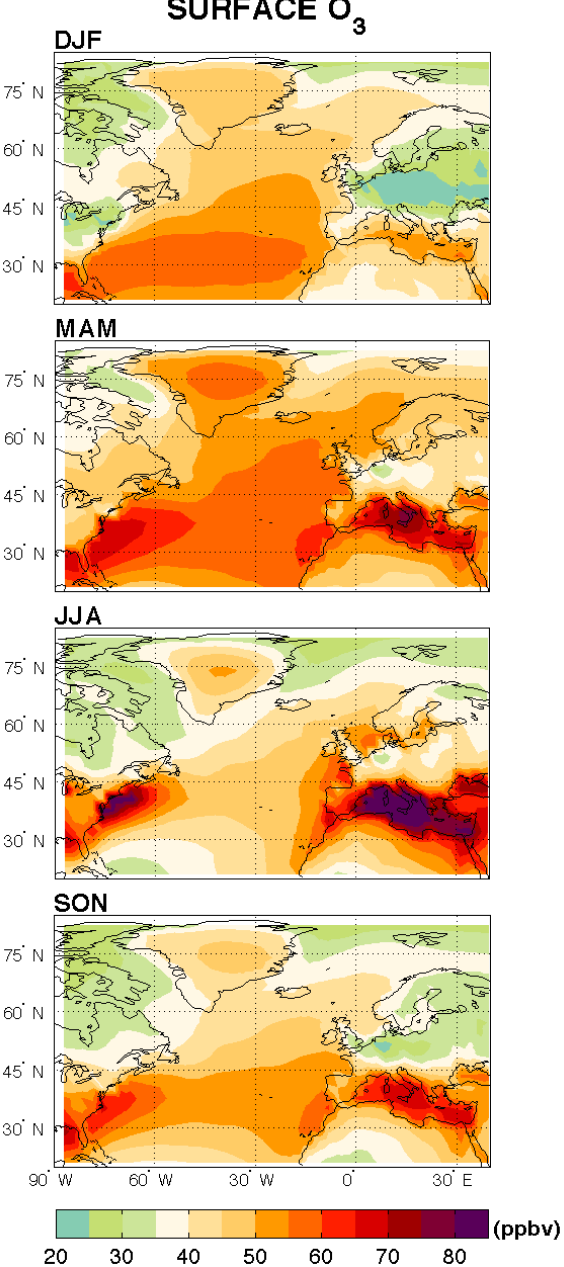
Fig. 2. Seasonal climatology (1980–2005) of modeled surface O 3 volume mixing